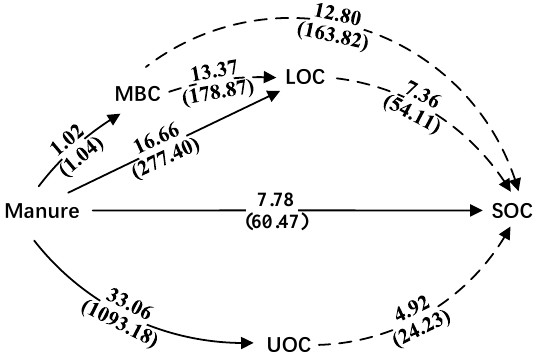
Figure 5. Path analyses between organic manure amount, SOC, and the various stable fractions. Solid and dotted lines denoted direct and indirect effects, respectively. Values indicated within lines are path coefficients reflecting the relative influence of manure on the dependent variables (SOC, LOC, UOC, and MBC) in the same path; those in brackets are coefficients of determination representing the degree of influence of manure on dependent variables in the same path.